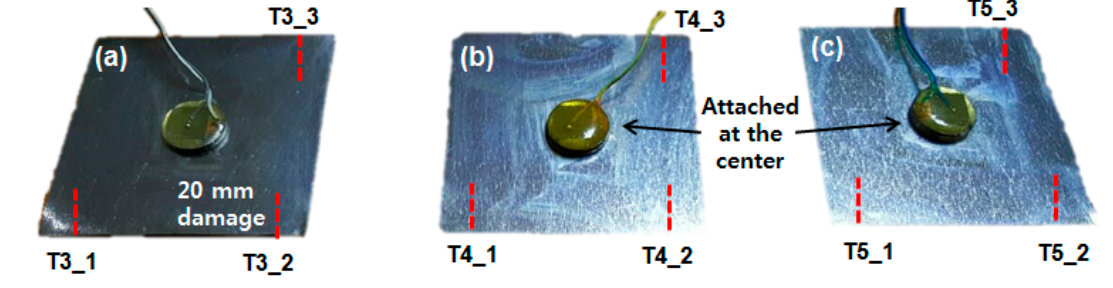
Figure 5. Test setup for ( a ) T3_x; ( b ) T4_x; ( c ) T5_x.